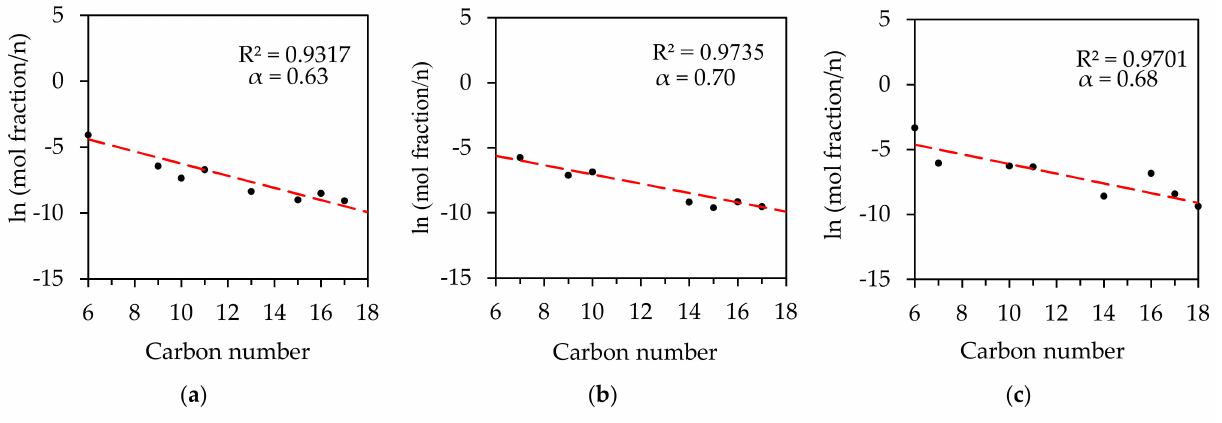
Figure 5. ASF plot and α values of ( a ) Fe/SiO 2 -h, ( b ) Fe/SiO 2 -c, and ( c ) Fe/SiO 2 -hc catalysts. Reaction conditions: T = 220 ◦ C, p = 1 atm, CO 2 /H 2 = 2/1, WHSV = 4920 mL/h.g. ( • ) experiment, ( − − − ) model fitting.